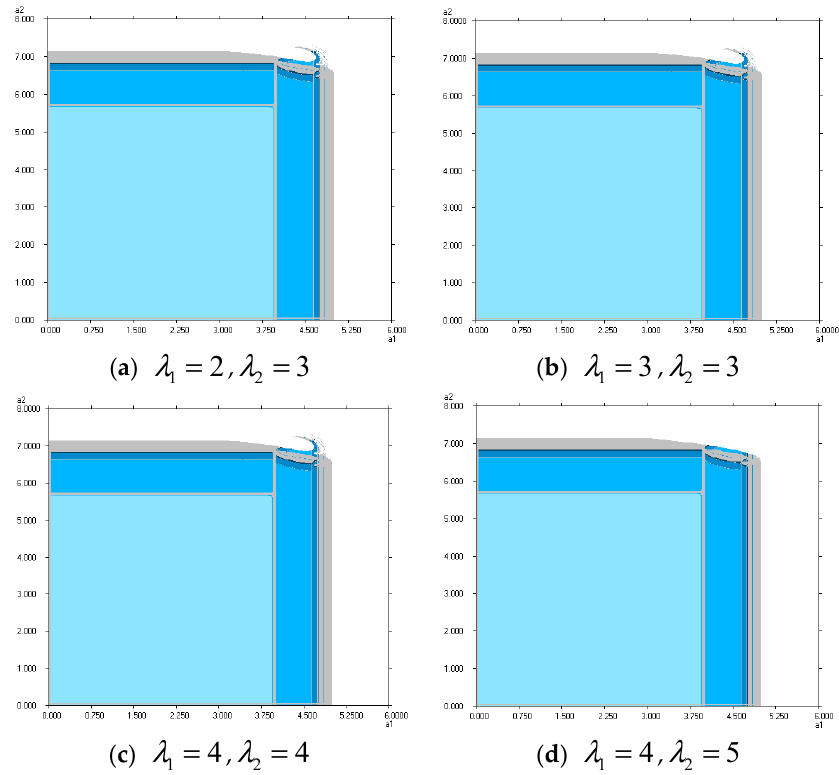
α α and with different 1 2